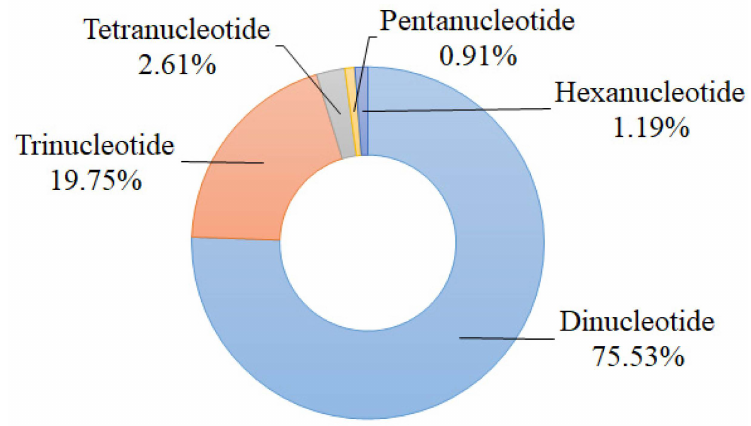
Figure 1. Statistics of types of candidate polymorphic nSSRs of S. tzumu